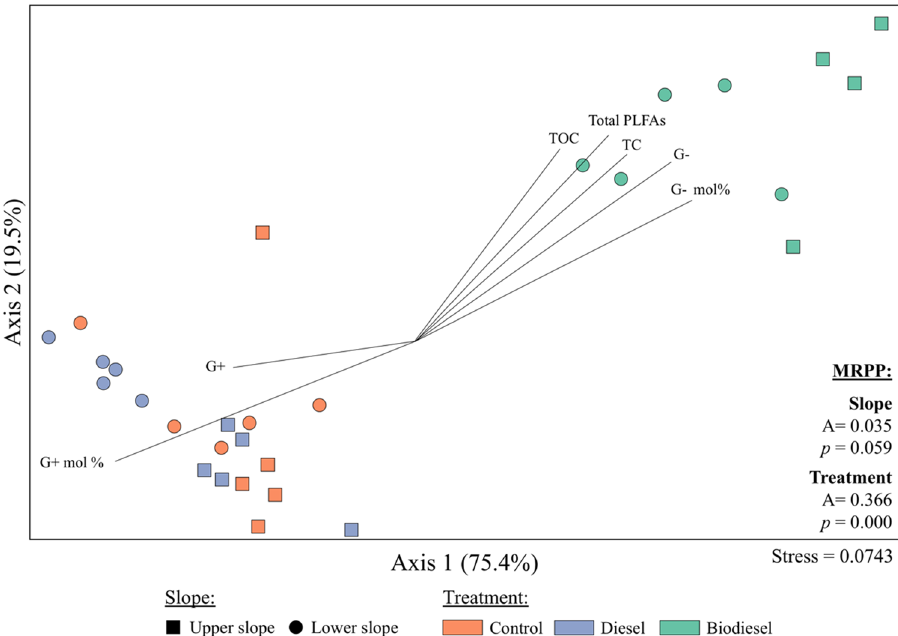
Figure 2. Two-dimensional solution of non-metric multi-dimensional scaling (MDS) ordination analysis and multiple response permutation procedure (MRPP) of PLFA profiles from an upper slope and lower slope soils under three different treatments (control, diesel and biodiesel). Percentage values in axes represent the percentage of variance explained by each axis. Vectors indicate direction and strength of relationships of specific PLFA groups and environmental variables (not included in matrix distance calculations). G+ and G− represent absolute Gram positive and and Gram negative biomarker abundance, respectively. Relative abundance G+ and G− biomarkers are shown as mol%. TOC = total organic carbon and TC = total carbon. The full list of soil parameters analyzed and specific PLFA biomarkers by treatment and slope are provided in Tables S2 and S3, respectively.